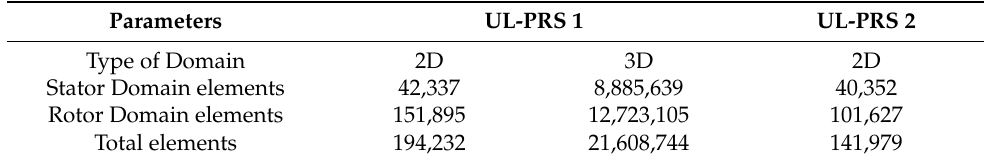
Table 1. UL-PRS 1 and UL-PRS 2 convergence mesh details.